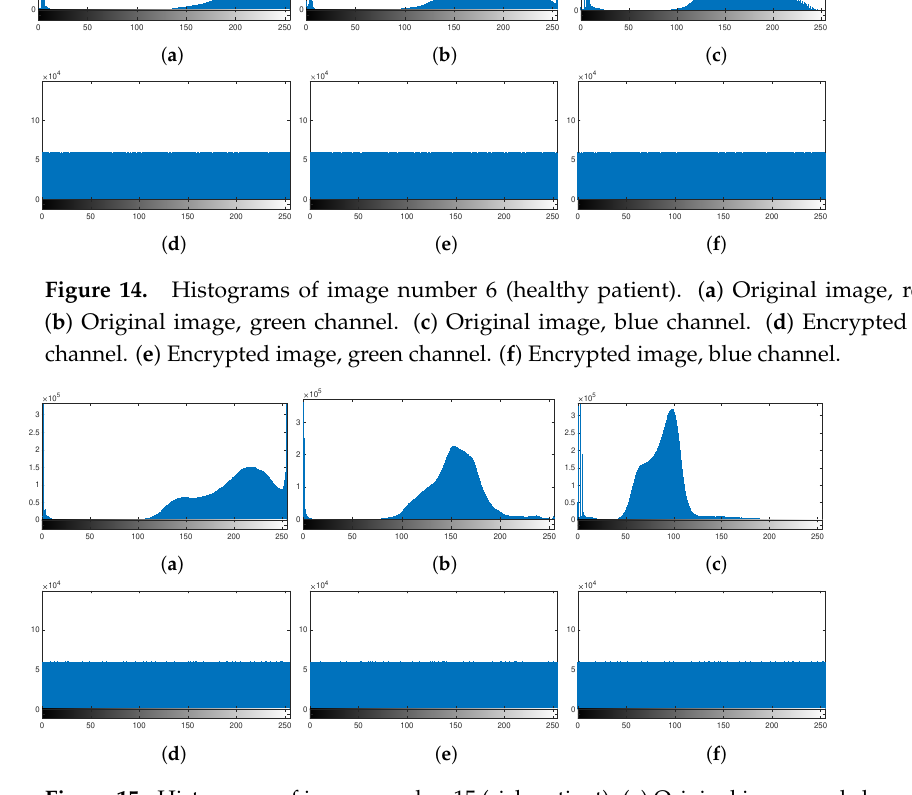
Figure 15. Histograms of image number 15 (sick patient). ( a ) Original image, red channel. ( b ) Orig- inal image, green channel. ( c ) Original image, blue channel. ( d ) Encrypted image, red channel. ( e ) Encrypted image, green channel. ( f ) Encrypted image, blue